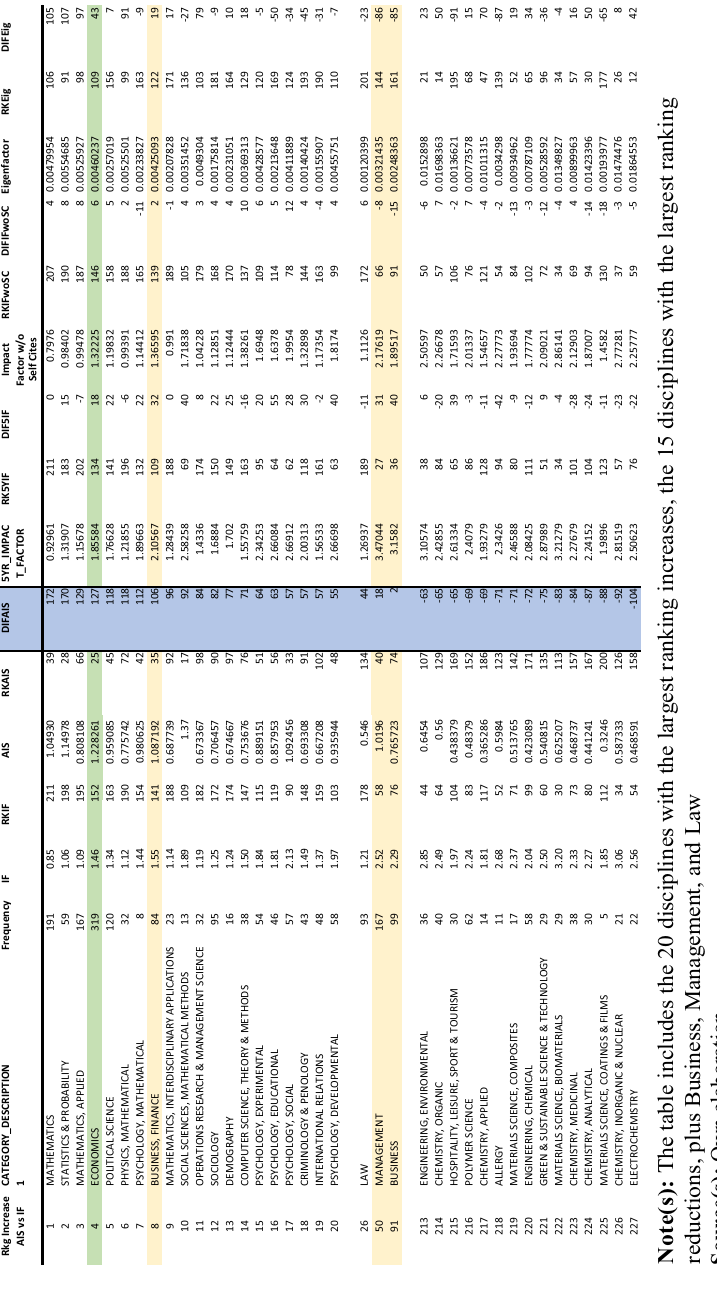
for disciplines when using AIS vs impact